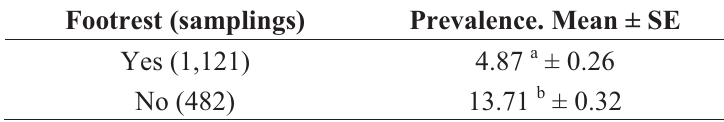
Table 3. Least squares means and standard errors for the footrest effect. There were 1,603 samplings and 105,009 lactating females examined on 413 doe farms, during